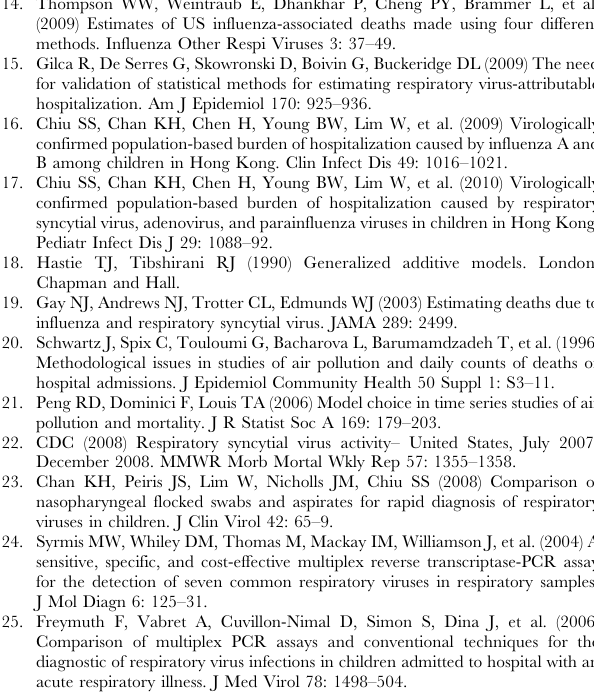
Table S1 Excess hospitalization rates associated